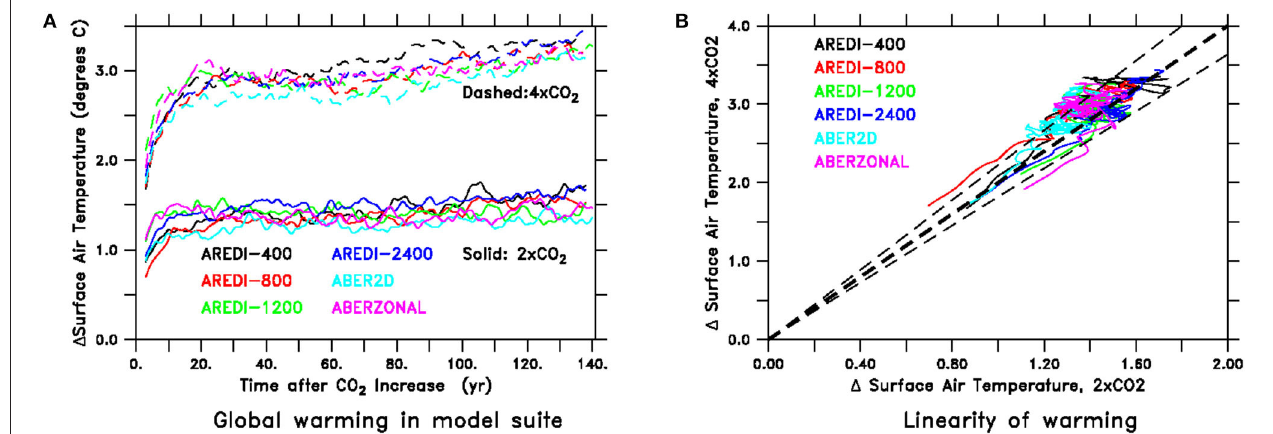
FIGURE 1 | Time-series of temperature response under global warming run for all six A REDI simulations. (A) Change in surface air temperature in ◦ C. Solid lines denote simulations under 2xCO 2 , dashed lines show the same simulations under 4xCO 2 . (B) Change in surface air temperature under 2xCO 2 (horizontal axis) vs. change in surface air temperature under 4xCO 2 . 2:1 Line is shown by thick dashed line. Points lying within thin dashed lines are within 10% of a 2:1 relation, meaning that the response under 4xCO 2 would predict the response under 2xCO 2 to within about